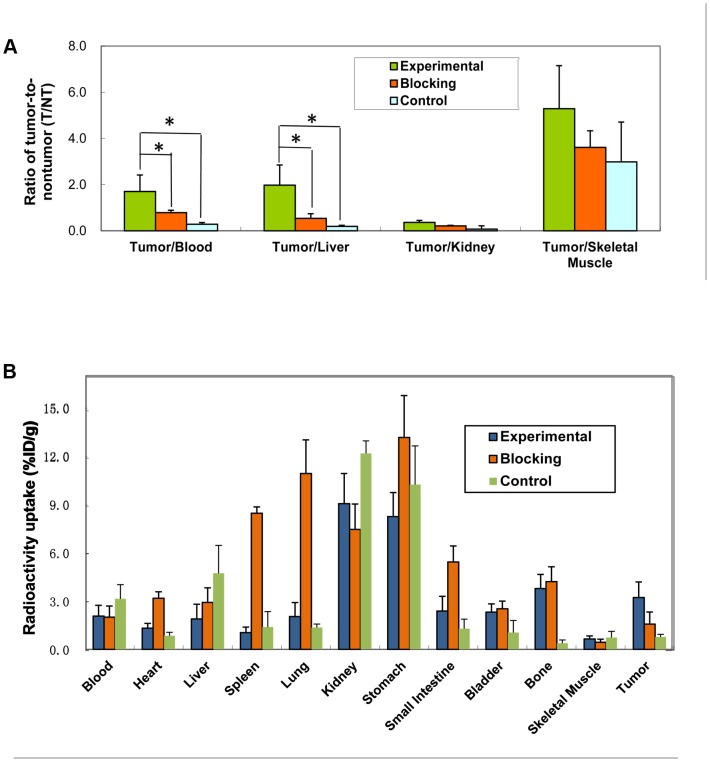
Biodistribution of 99mTc-RRL in HepG2 xenograft-bearing mice.The ratio of T/NT of blood, liver, kidney and skeletal muscle showed better biodistribution of the probe (A). T/B and T/L ratio of experimental group were significant higher than that of blocking or control group. ‘*’ represented P<0.05. Comparison of %ID/g of interesting organs among experimental, blocking and control group at 6 h post injection was shown (B). Data were expressed as the mean value ± SD (n = 5). Higher uptake of kidneys and bladder caused by the probe clearance, yet higher stomach uptake was because of the uptake of free technetium-99 m.